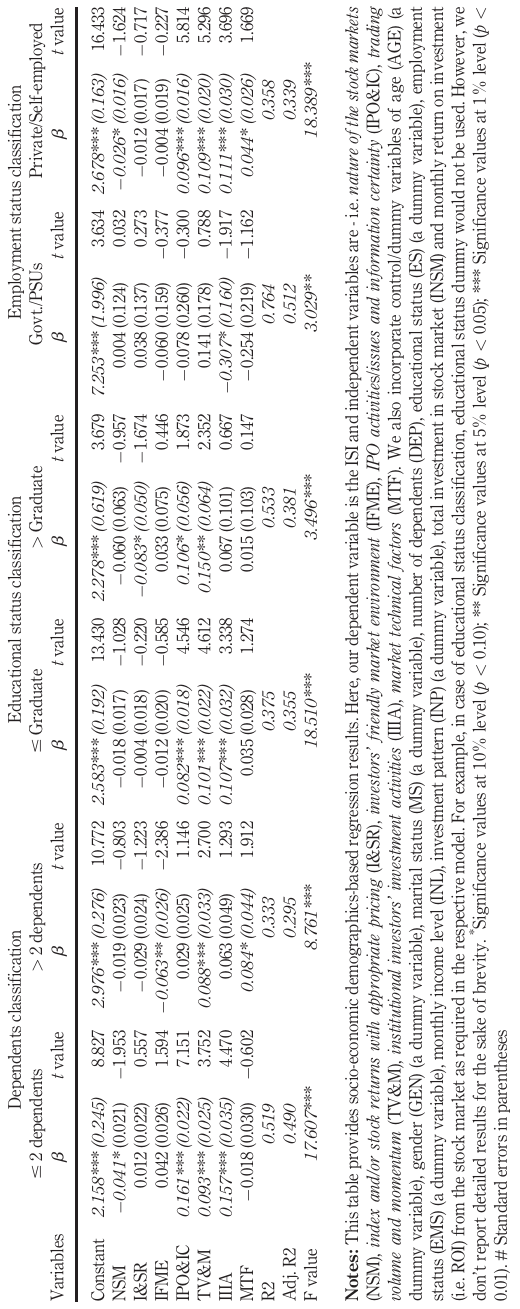
Table 5. Regression results (socio-economic